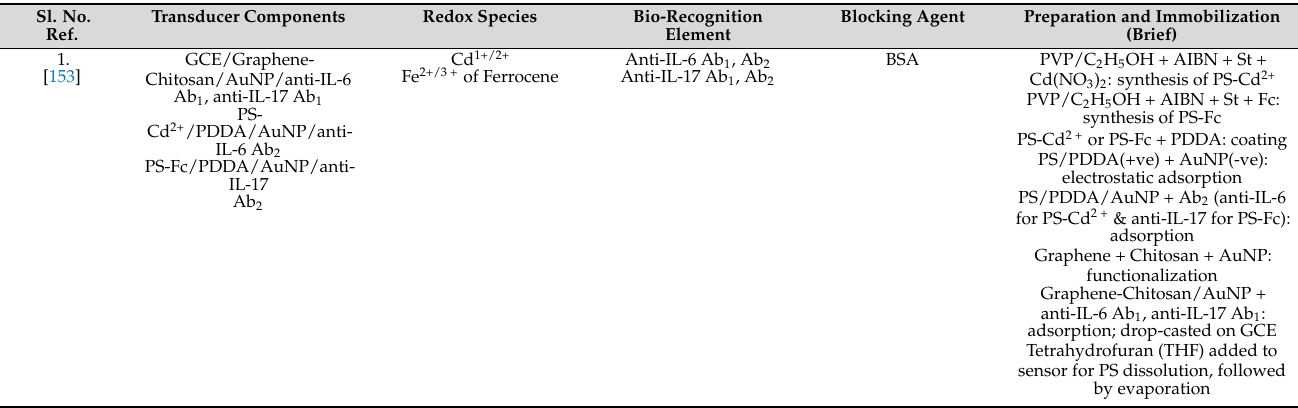
Table 17. Biosensors for multiplexed cytokine detection: Design and sensor preparation. Sl. No.